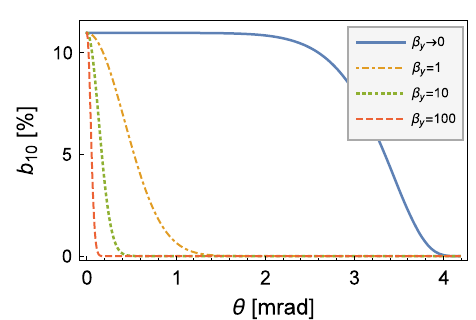
FIG. 5. In the HGHG mechanism, the bunching factor at 10-th harmonic b 10 as a function of the laser incident angle θ with different beta